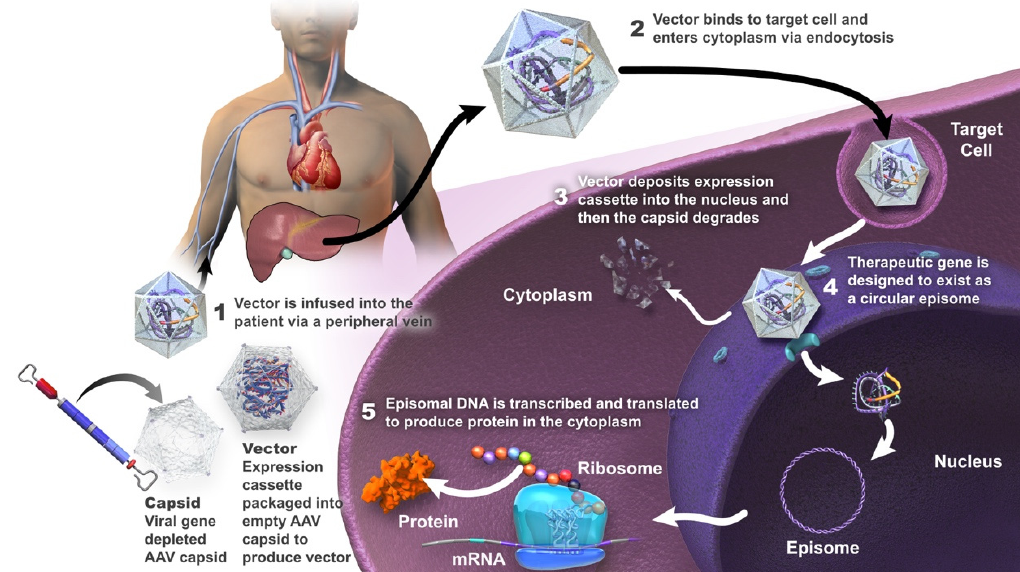
Figure 1. Summary of mechanism of action of gene therapy using an adeno-associated viral (AAV) vector.